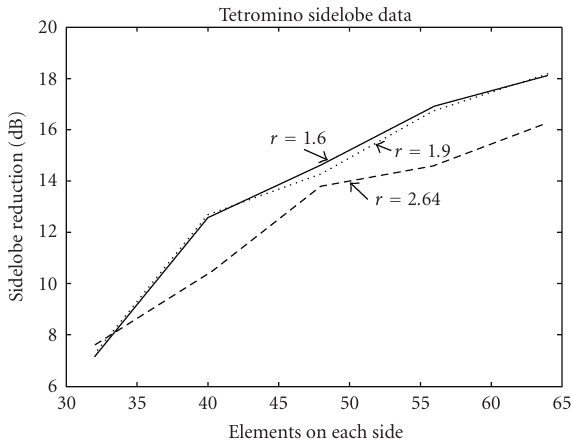
Figure 13: Sidelobe reduction factor (max rectangular subarray quantization lobe level—largest octomino sidelobe level) dB for moderate and wide band